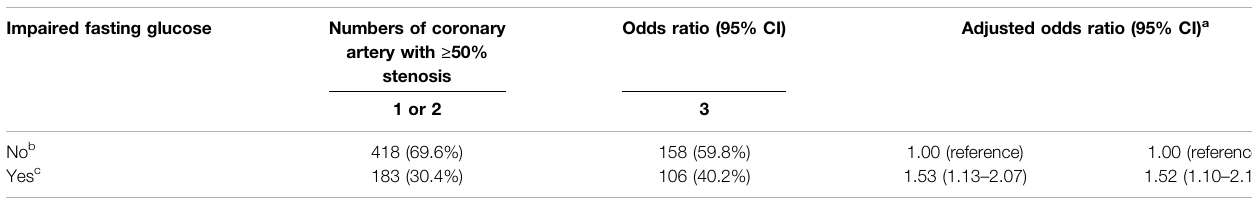
TABLE 2 | Impaired fasting blood glucose and extent of coronary artery disease.